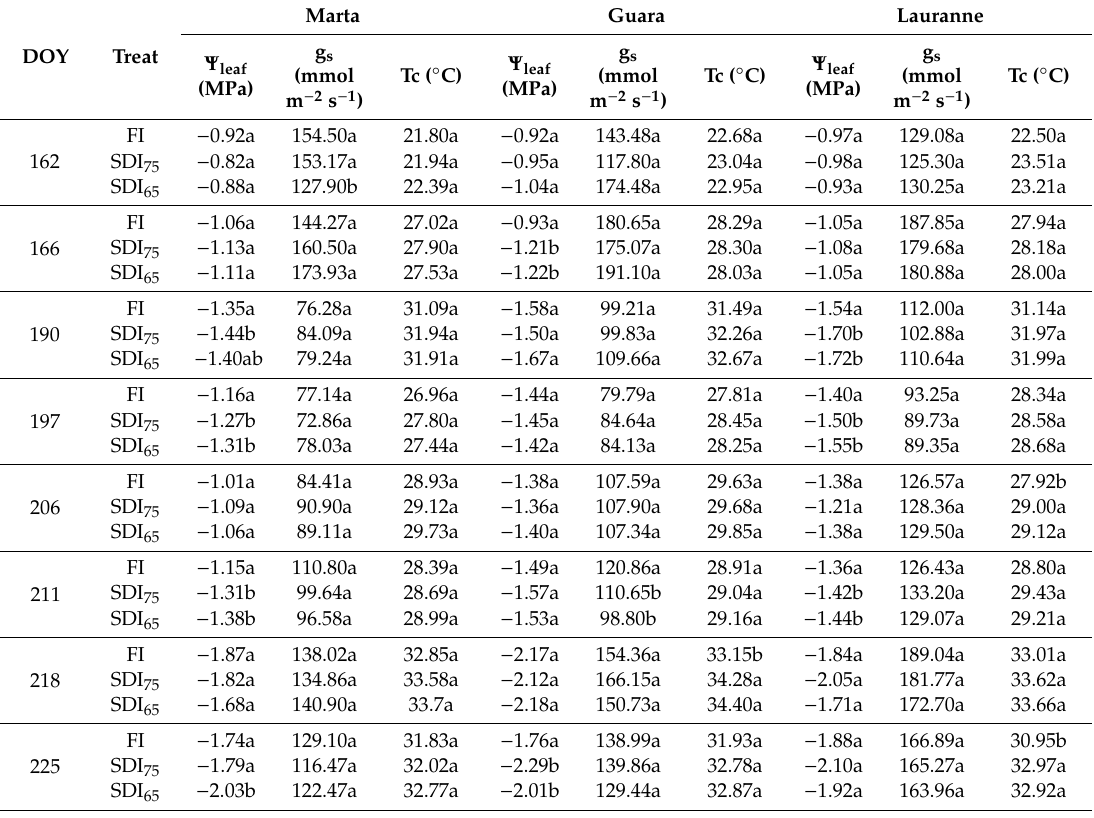
Table 3. Temporal evolution of the physiological variables measured throughout